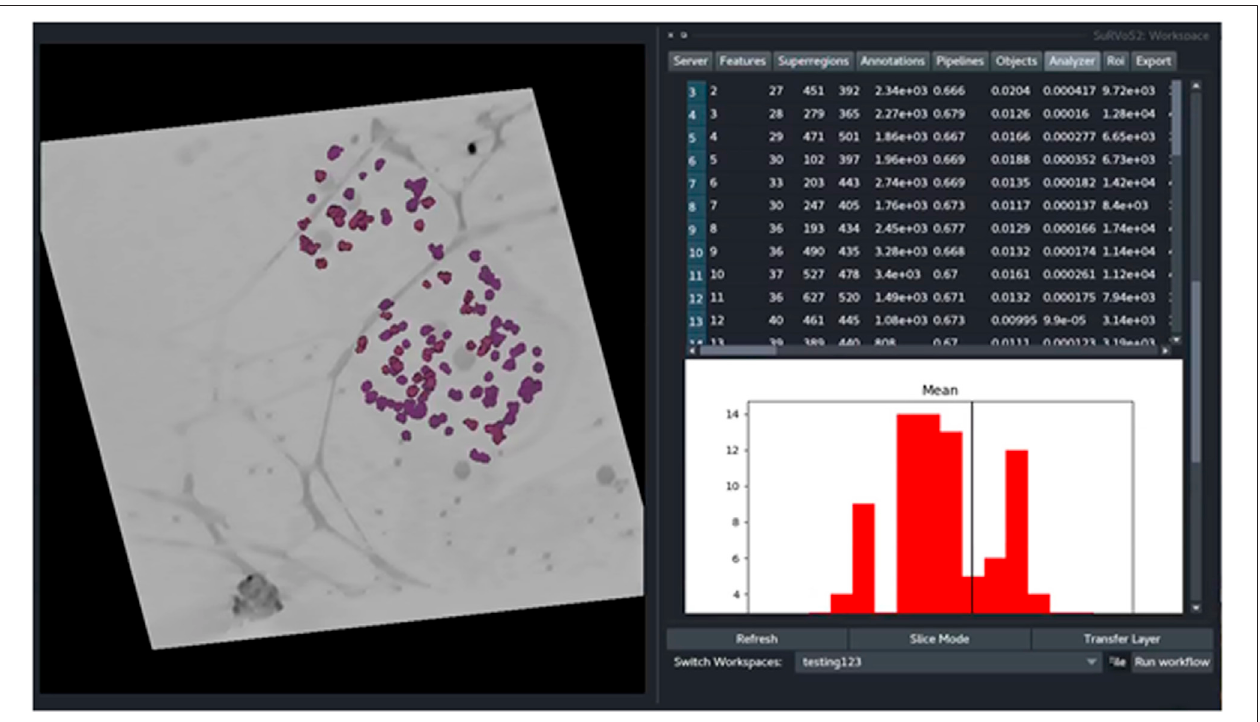
FIGURE 4 | The Label Splitter tool for application of classi fi cation rules using inherent characteristics of the segmented objects. Information about each object is displayedonatableandgraph.Thegraphissplitbyalineatthelocationofthechosenrulevalueanddoubleclickingonanentryinthetabletakestheusertothechosen object in the